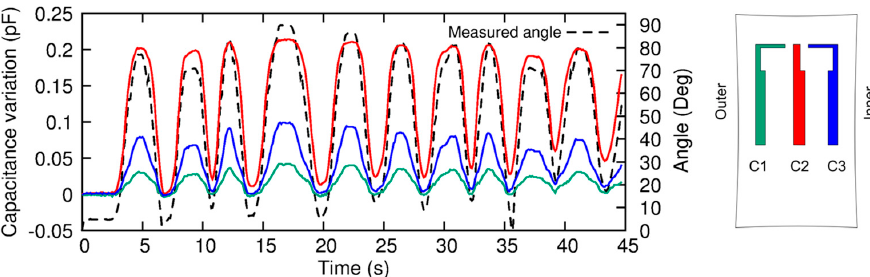
Figure 7. Capacitance variations of the three sensors (green, red and blue solid lines for C1, C2 and C3, respectively) compared with the angle (black dashed line) measured by the tracking optical system.